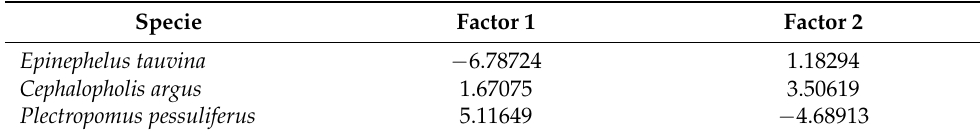
Table 13. Factor